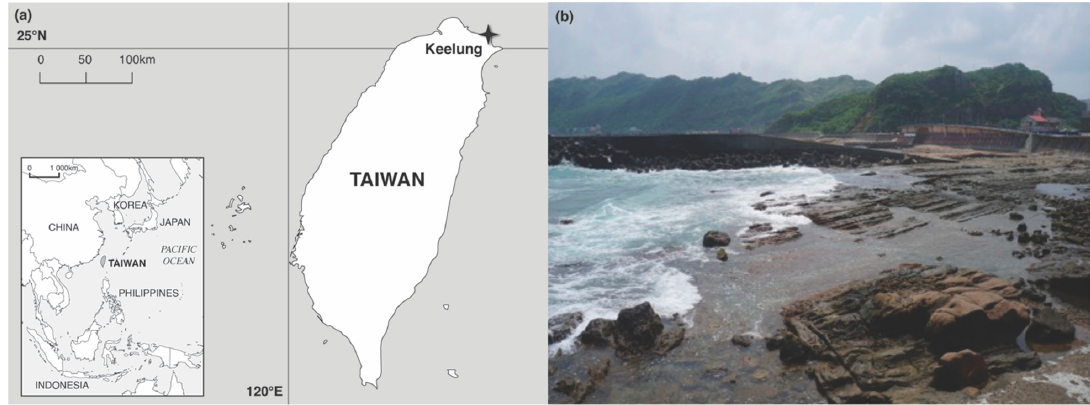
Figure 1. Sampling site: ( a ) Sampling location (star) of Pterocladiella capillacea along Chao-Jin Park, Keelung, northern Taiwan. ( b ) Photograph of the sampling site.